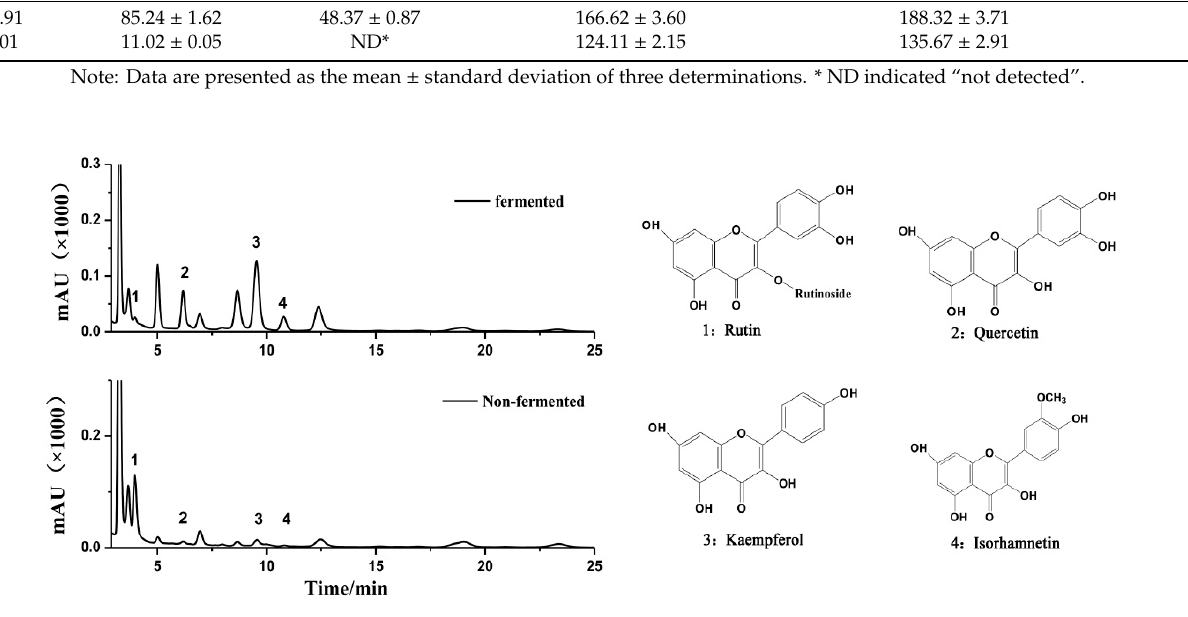
Figure 5. HPLC profiles of flavonol aglycones in non-fermented and fermented HRL. Numbers above the peak were corresponding to the compounds listed on the right. Table 1. Contents of aglycones and antioxidant activities of non-fermented and fermented HRL.